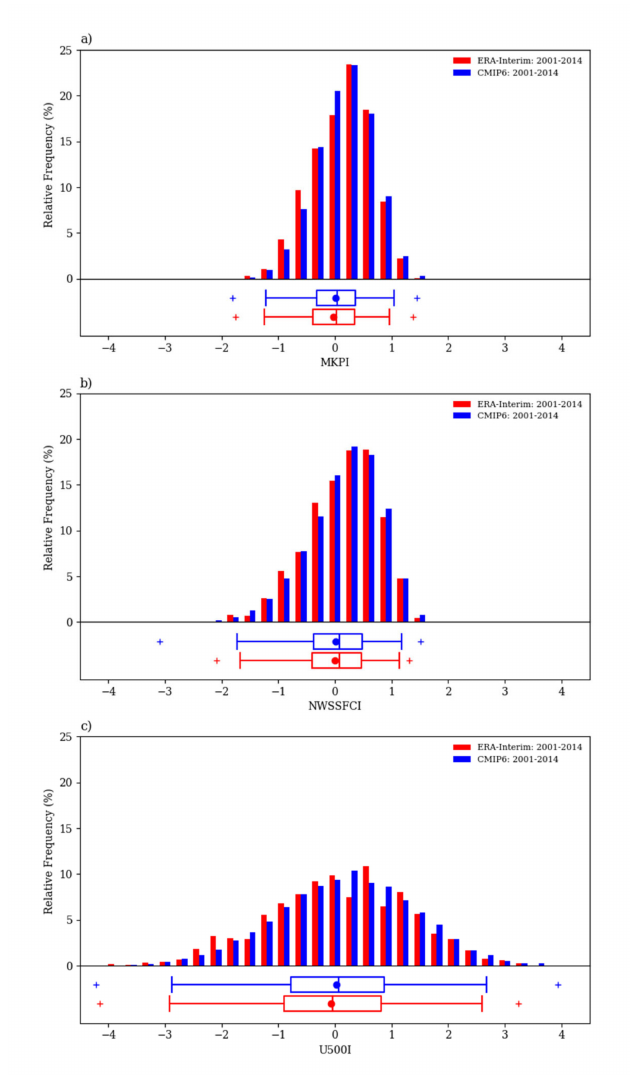
Figure 6. Histogram showing the frequencies of occurrence (in percent) of daily indices: ( a ) modified Korea particulate index (MKPI), ( b ) negative wind speed at surface index (NWSSFCI), ( c ) 500 hPa u-wind index (U500I) for ERA-Interim and CMIP6 ensemble models during the winters of the 2001–2014 period. The horizontal boxplots show the solid horizontal lines within each ‘box’ representing the median, and the circle markers indicate the mean. The interquartile range is 25th and 75th percentiles. The ‘whiskers’ represent the 1st and 95th percentile. The cross-markers denote the highest or lowest ‘outlier’ of each case. Results for ERA-interim (red) and CMIP6 (blue) are